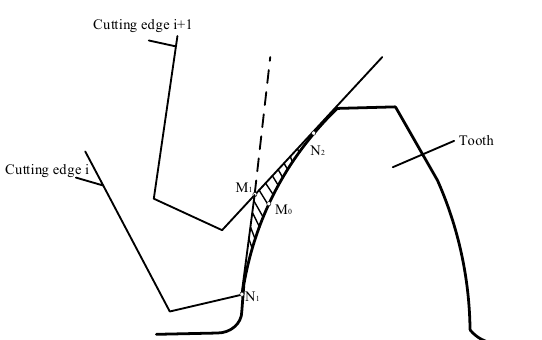
Figure 2 Diagram of roughness formation on machined surfaces